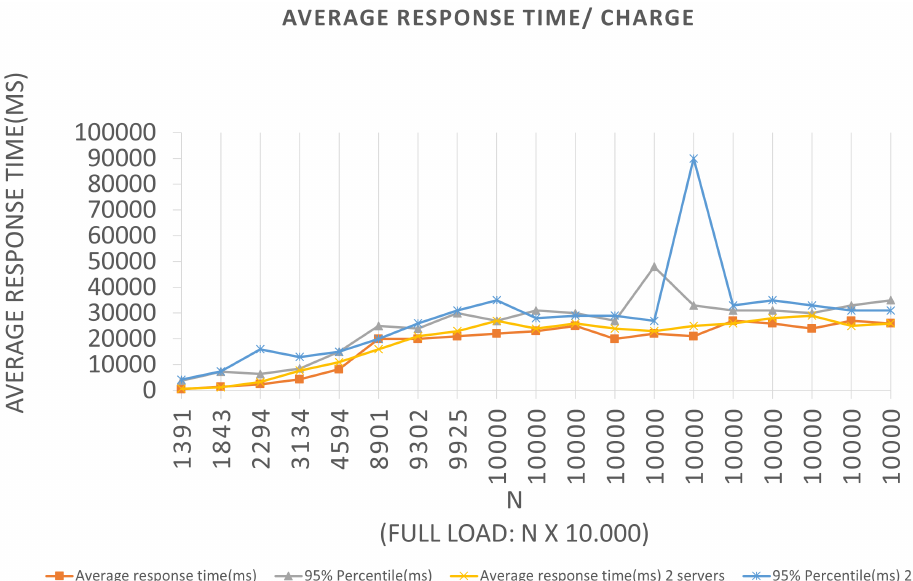
Figure 15. Results of the experiments for query